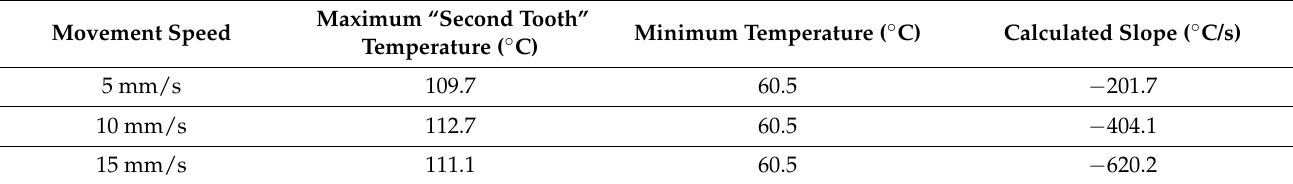
Table 5. Comparison of cooling processes of the material for various movement speeds of the printer